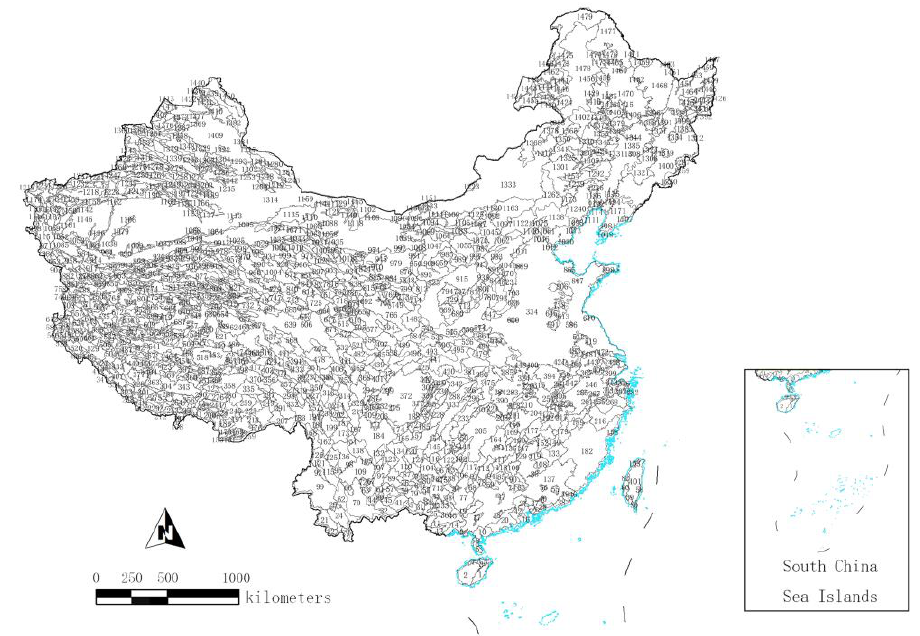
Figure 6. Combined artificial adjustment of the regional map of 1483 landscape character areas (LCAs) in China.